Question: Give a one-sentence summary of this figure.
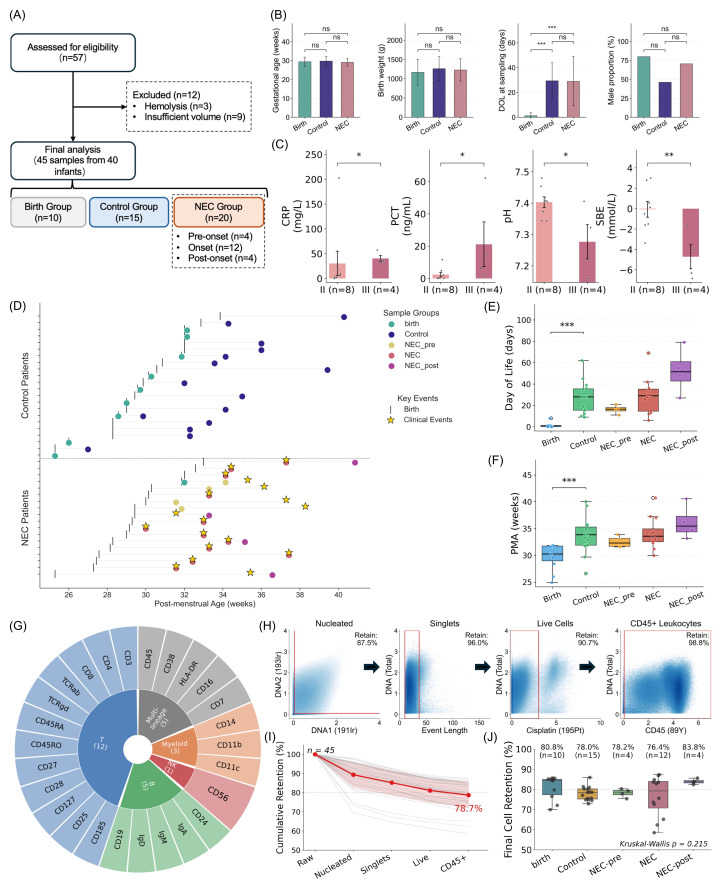
Answer: A quality-controlled neonatal CyTOF cohort enables immune profiling across NEC progression. (A) Flow diagram of cohort inclusion and exclusion. Fifty-seven samples were assessed for eligibility; 12 were excluded because of hemolysis or insufficient blood volume, leaving 45 samples from 40 infants for final analysis. The final cohort comprised Birth, Control, NEC-pre, NEC-at-onset, and NEC-post samples. (B) Baseline and sampling characteristics across Birth, Control, and NEC groups, including gestational age, birth weight, day of life at sampling, and male proportion. Bars show group summaries with pairwise statistical annotations. (C) Representative onset clinical variables comparing Bell stage II and stage III NEC, including C-reactive protein, procalcitonin, pH, and standard base excess. (D) Per-patient sampling timeline plotted by postmenstrual age, with sample groups and key clinical events indicated. (E, F) Day of life and postmenstrual age distributions across the five sample groups. (G) 26-marker antibody panel design summarized by lineage and functional marker category. (H) Representative gating workflow for the OPTIMAL preprocessing pipeline, including nucleated cells, singlets, live cells, and CD45+ leukocytes. (I) Cumulative retention across preprocessing steps for all valid samples. (J) Final CD45+ cell retention by group. Unless otherwise indicated, continuous variables were compared using nonparametric tests and multiple-group comparisons were adjusted as appropriate; *, P < 0.05; **, P < 0.01; ***, P < 0.001; ns, not significant. CD, cluster of differentiation; CRP, C-reactive protein; DOL, day of life; NEC, necrotizing enterocolitis; PCT, procalcitonin; PMA, postmenstrual age; SBE, standard base excess.